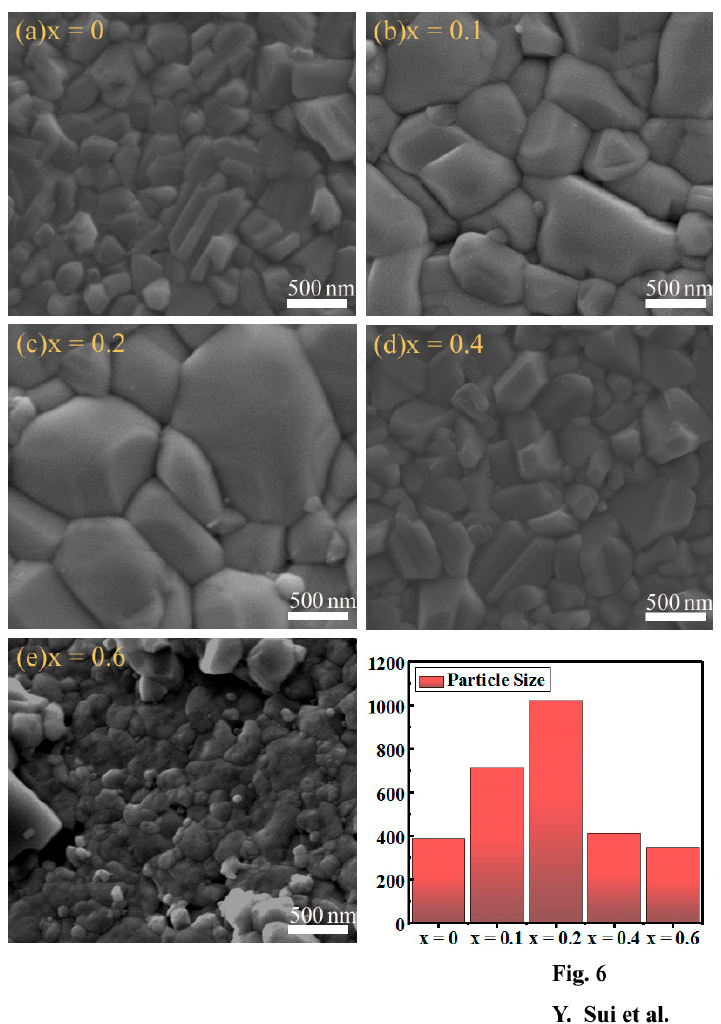
Figure 6. SEM images of Cu 2 Mg x Zn 1- x SnS 4 (0 ≤ x ≤ 0.6) thin films with different Mg content: ( a ) x = 0, ( b ) x = 0.1, ( c ) x = 0.2, ( d ) x = 0.4 and ( e ) x = 0.6. Inset: The average diameter of particles as a function of the Mg content.